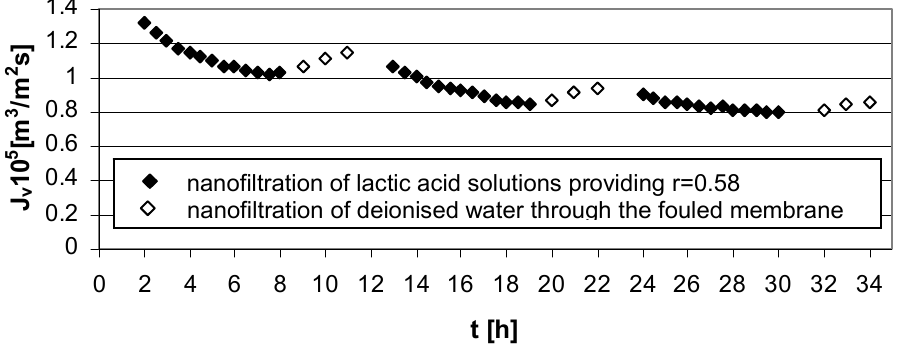
= 1.0 mol/dm 3 , LA